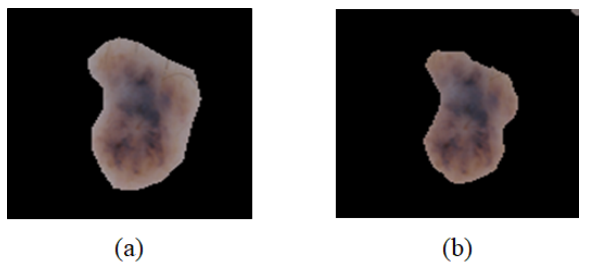
Figure 7. Images of skin lesion areas extracted based on the binary splitting image. ( a ) Labeling-based area and ( b ) predicted area based on U-Net.